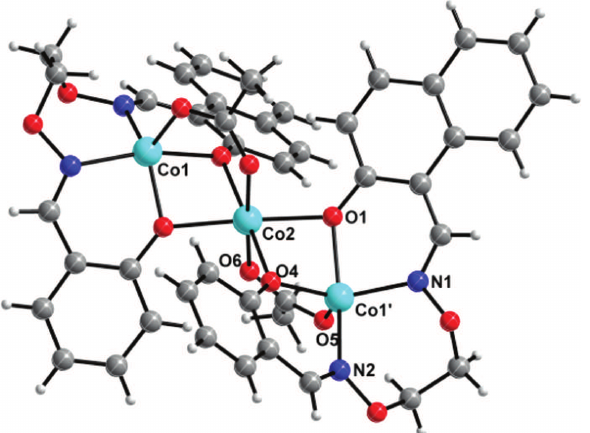
Table 1: Data collection and